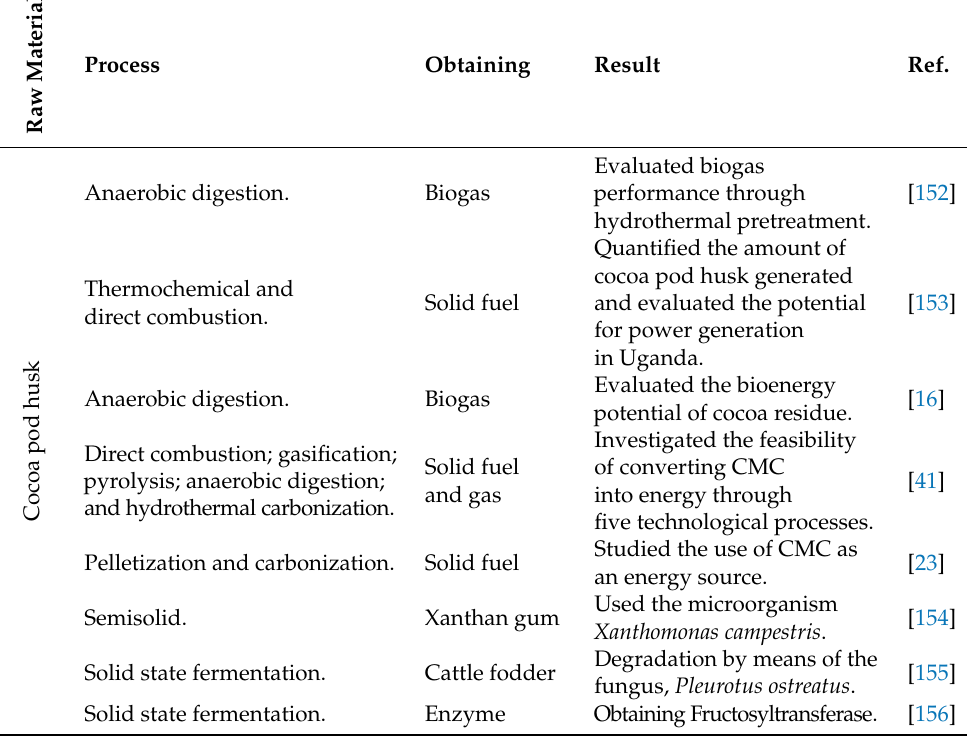
Table 6. Bioenergetic strategies for the use of